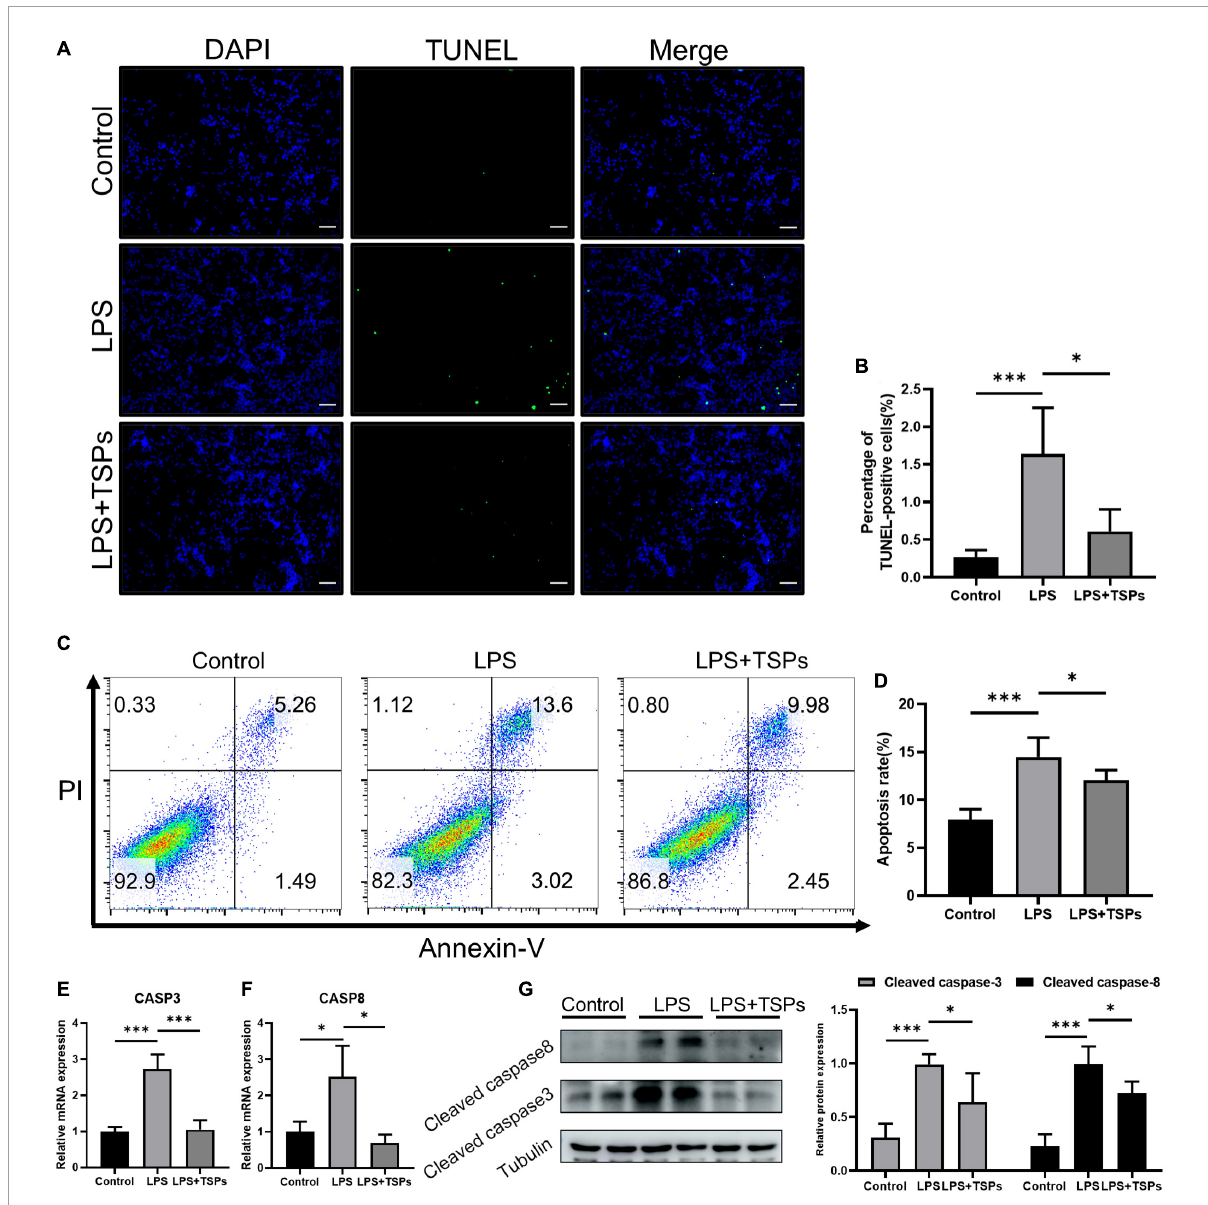
FIGURE2 TSPs prevented LPS-Induced Apoptosis in CT-26. (A) Representative images of TUNEL staining in CT-26 cells. Scale bar = 100 µ m. (B) Quantification of the percentage of TUNEL positive cells ( n = 6). (C) Apoptosis analysis of CT-26 cells by flow cytometry. (D) The results of quantitative analyses of apoptosis rate ( n = 5). (E,F) Caspase-3 and caspase-8 levels were measured by qRT-PCR ( n = 3). (G) Western blot analysis of the cleaved caspase-3 and cleaved caspase-8 proteins in CT-26 cells and semi-quantitative analysis of relative indicated proteins expression ( n = 4). Data were presented as means ± SD. Statistical significance was determined using one-way ANOVA. ∗ P < 0.05, ∗∗∗ P <